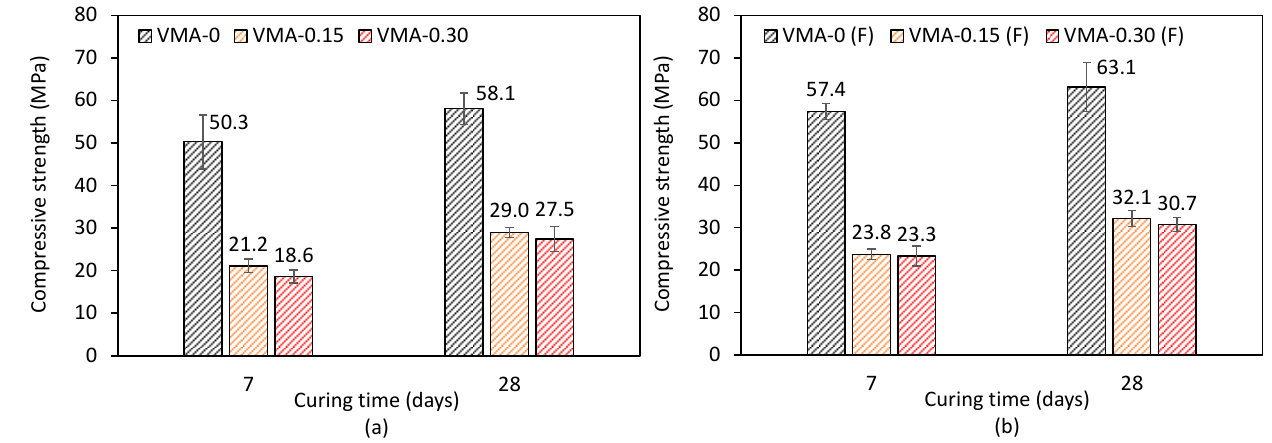
Figure 12. Compressive strength of the extruded specimens for fiber-free ( a ) and fiber-reinforced ( b ) mixtures.